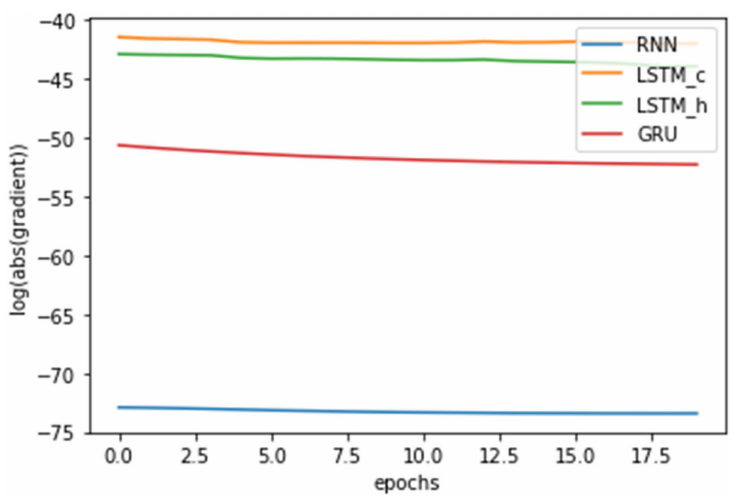
Figure 5. Changes of the derivatives of the three models over